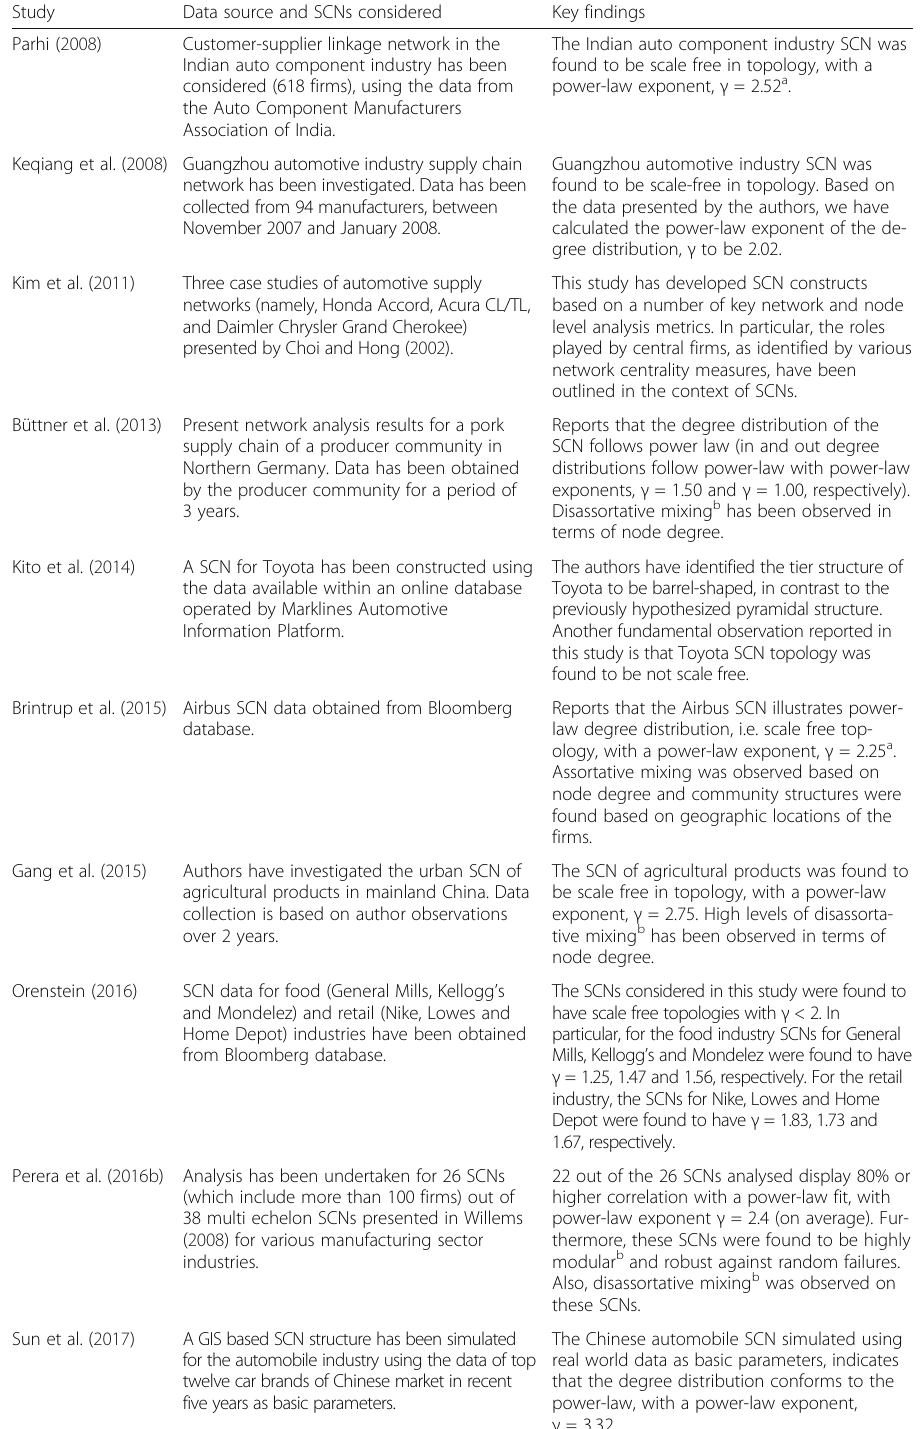
Table 3 Summary of empirical studies of SCN